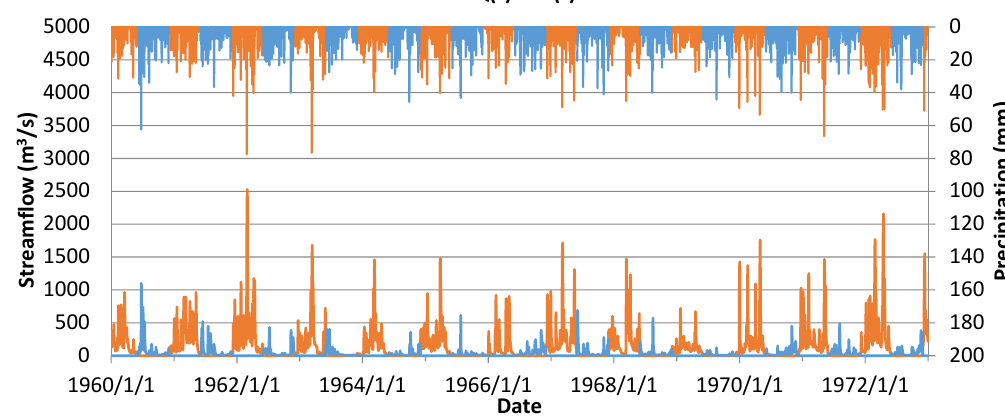
Figure 3. Streamflow and precipitation record for the validation dataset. Red represents the high flow seasons while blue represents the low flow seasons.